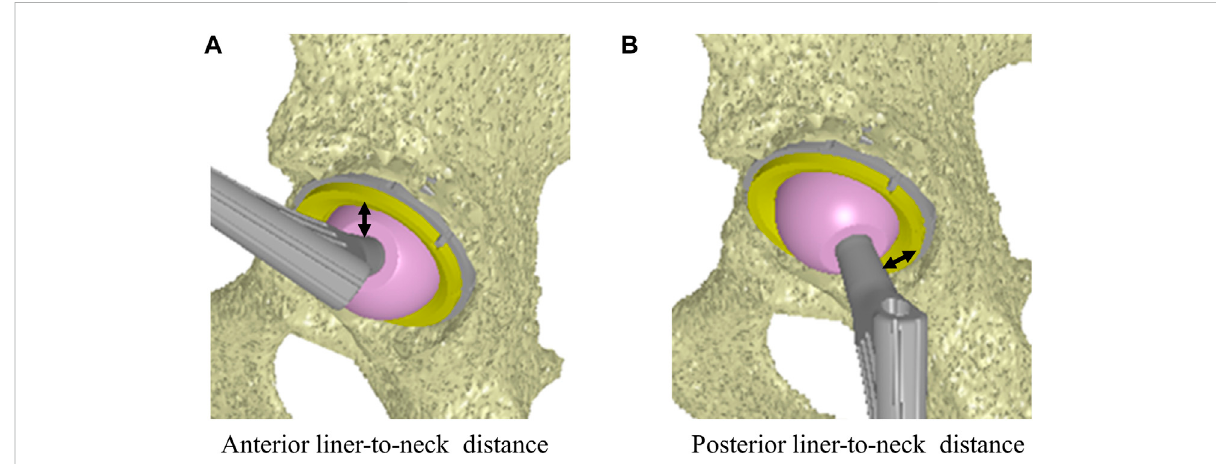
FIGURE 3 Minimum distance on the anterior side to the stem at the maximum hip fl exionas the anterior liner-to-neck distance (A) . Minimum distance on the posterior side to the stem at the maximum hip extension as the posterior liner-to-neck distance (B)